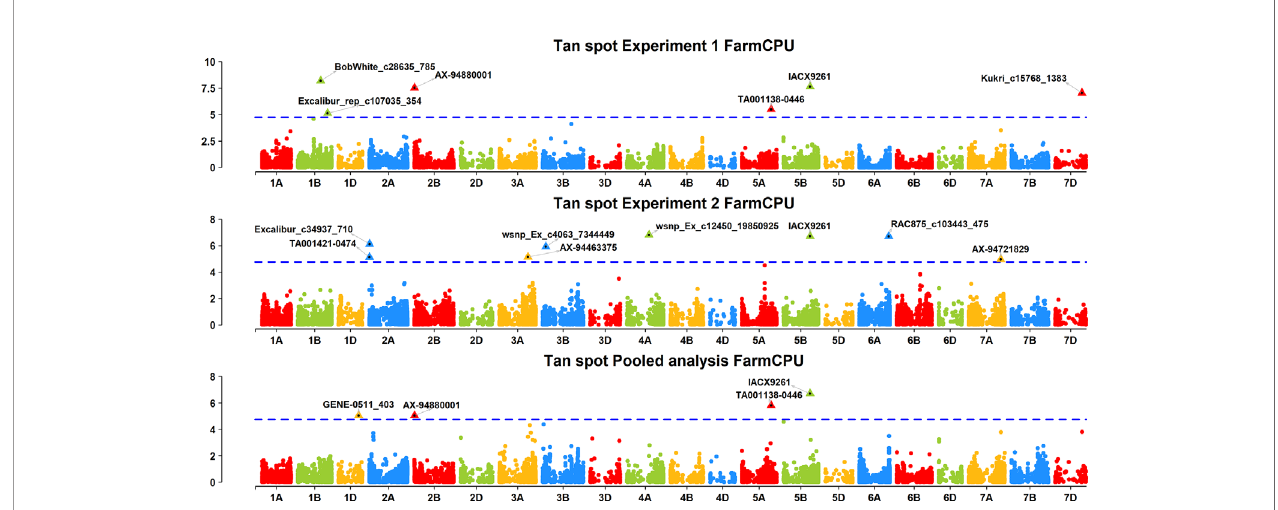
FIGURE 4 | Manhattan plots based on FarmCPU model indicating associated markers and chromosome in experiment 1, experiment 2 and pooled analysis. Foot note: X axis — chromosomes, Y axis — LOD